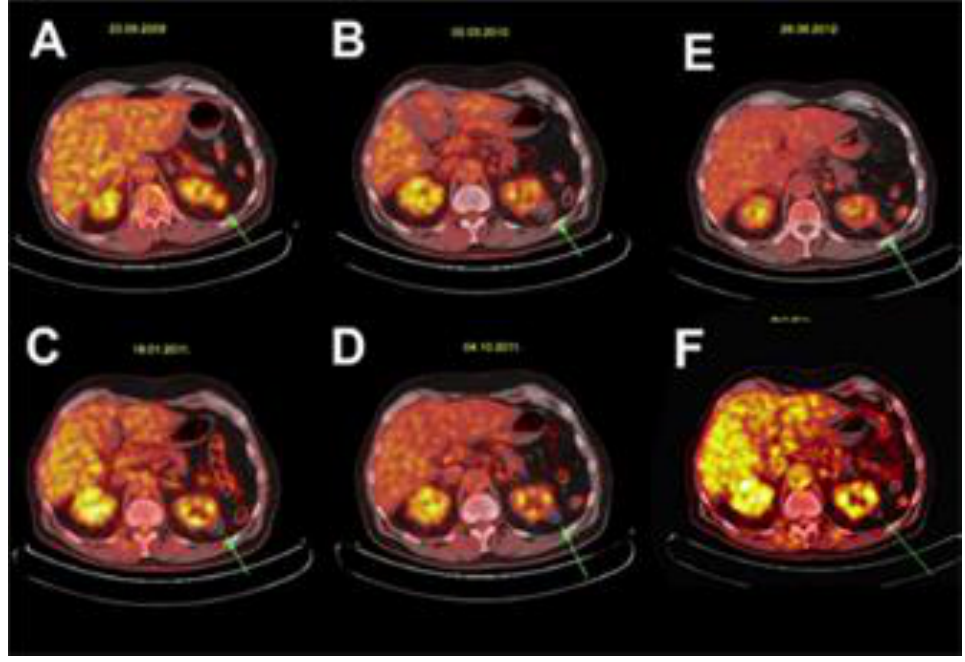
Figure 2. Consecutive 18 F-FDG PET-CT imaging of a renal cancer before and after cryoablation: Green arrows indicate the tumor or the ablation site in the left kidney of patient number 4. Before surgery, ( A ) there was metabolic activity noticed in the tumor. The low-dose CT scans showed consecutive decrease in the tumor volume, and no metabolic activity was measured in the tumor using 18 F-FDG PET at 5 months ( B ), 15 months ( C ), and 24 months ( D ) follow-up after LCA. However, at 34 months, newly developed metabolic activity was noticed in the perirenal fat that covered the ablated tumor (green arrow panel E ). Spontaneous disappearance of metabolic activity in the perirenal fat at 63 months ( panel F